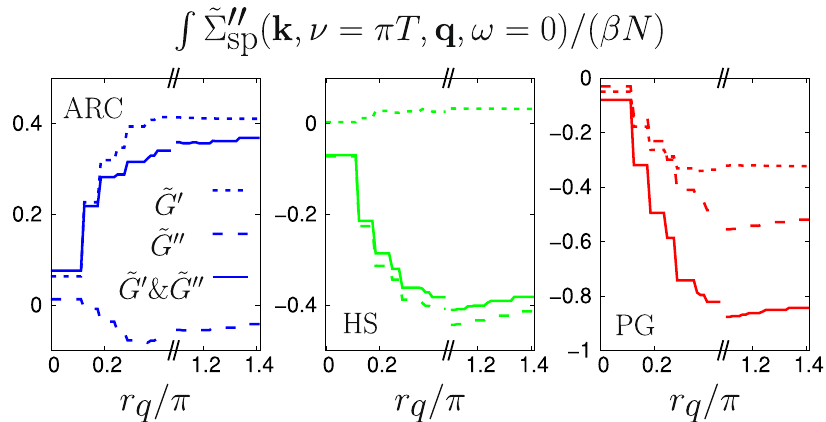
Fig. 5 Integrated fl uctuation diagnostic (normalized by particle number N and inverse temperature β ) for δ = 0.01 as a function of the integration radius r q (cf. circles in Fig. 1, see text). Dotted and dashed lines show the separate contributions of real and imaginary part of the dual Green ’ s function ~ G , respectively.